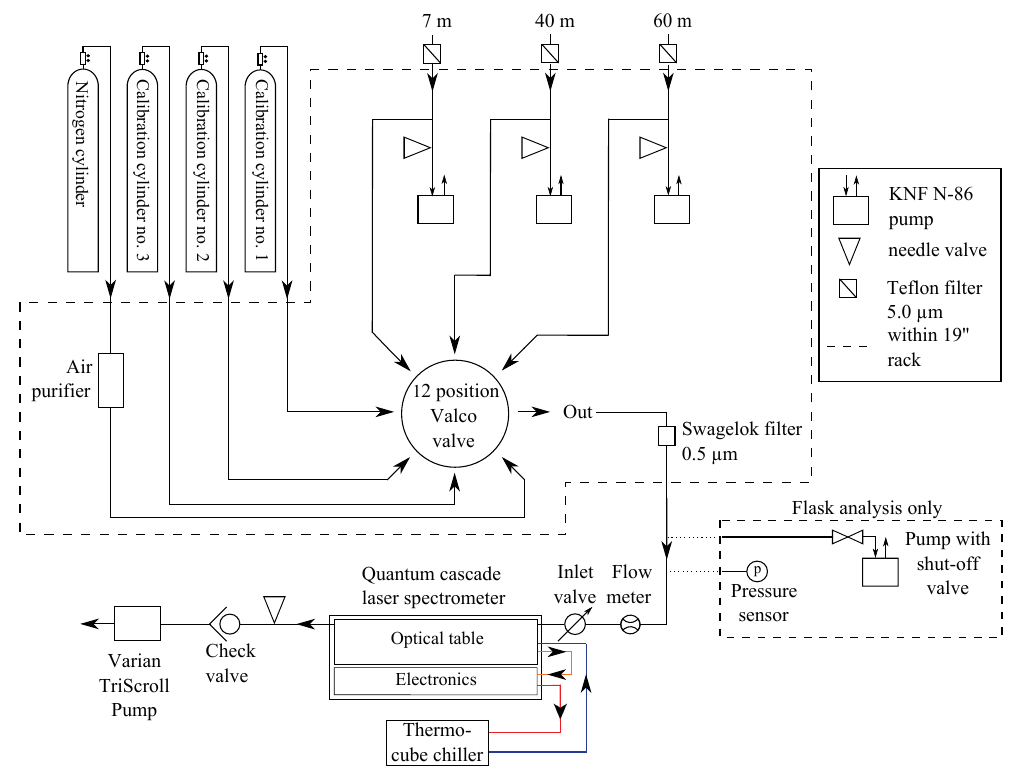
Figure 4. Schematic overview of the instrument setup for tower profile measurements at the Lutjewad monitoring station. The pressure sensor and pump with shut-off valve were added for flask measurements only (see Sect.